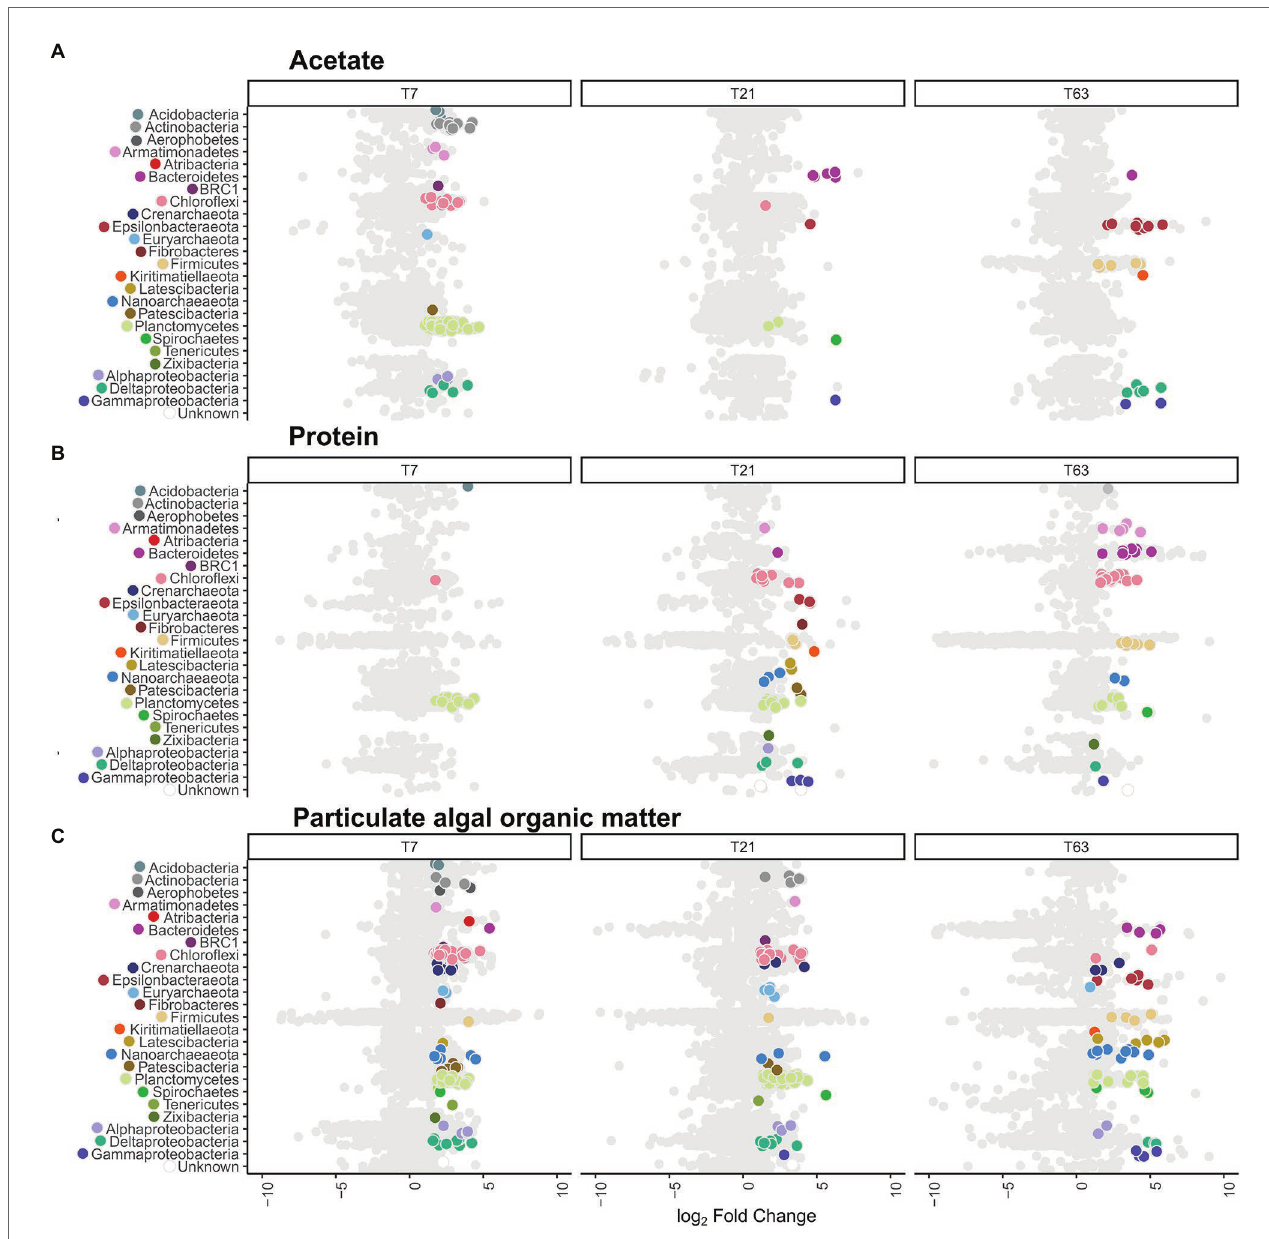
FIGURE 3 | Distribution of active operational taxonomic units (OTUs) and their taxonomy compared to all OTUs. Data shown is ordered by substrate type and sampling timepoints day 7 (T7), day 21 (T21), and day 63 (T63). The x-axis depicts the difference in abundance between the heavy fractions of the labeled and unlabeled incubations as the log2 fold change calculated with DeSeq2 in the high-resolution DNA-SIP (HRSIP) workflow as indicated in the Experimental procedures. (A) Acetate-amended incubations, (B) Protein-amended incubations, and (C) PAOM-amended incubations. Each dot represents an individual OTU. Light gray dots represent unlabeled OTUs, while colored dots are OTUs were determined as labeled by the HRSIP analysis. Dots are color-coded by taxonomic information with colors corresponding to the ones used in Figure 2